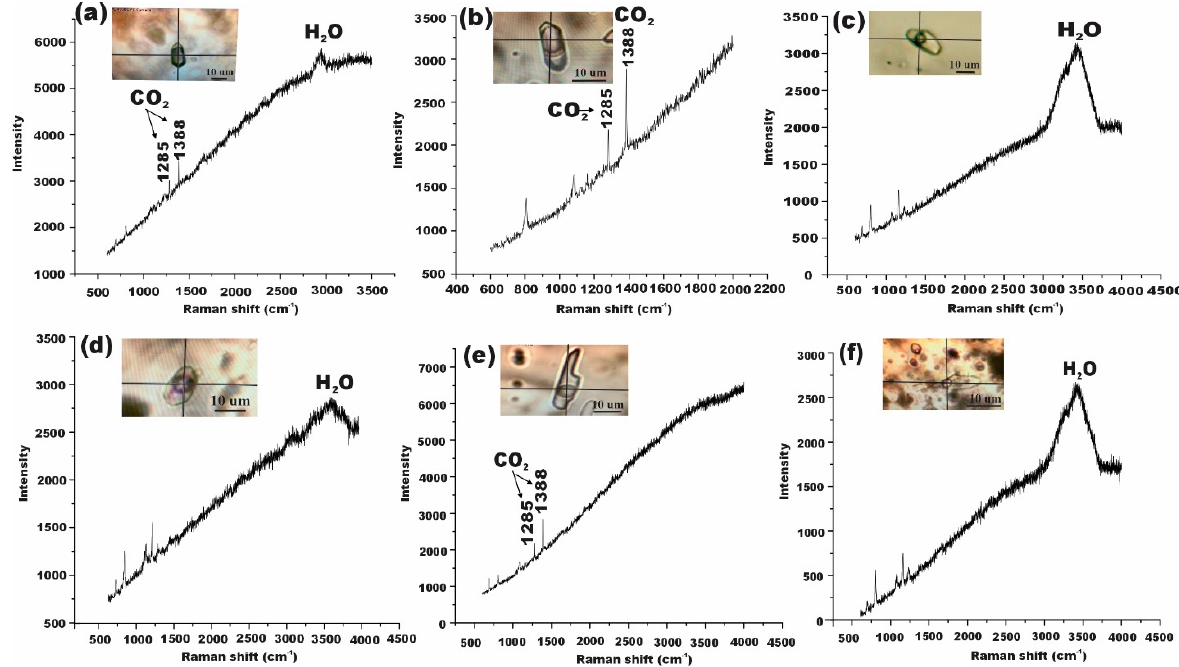
Figure 9. Representative laser Raman spectra of fluid inclusions of the magmatic-hydrothermal Cu-Pb polymetallic mineralization, Kargah: ( a ) H 2 O and CO 2 spectrums in type II inclusions of the pre-ore stage; ( b ) type III inclusions of vapor in the pre-ore stage; ( c , d ) H 2 O spectrums of vapor in type IV and type II inclusions of the pre-ore and sulfide ore stage II, respectively; ( e ) CO 2 spectrum in type III inclusion of vapor in sulfide ore stage I; ( f ) type IV inclusion in the calcite vein of the post-ore stage.